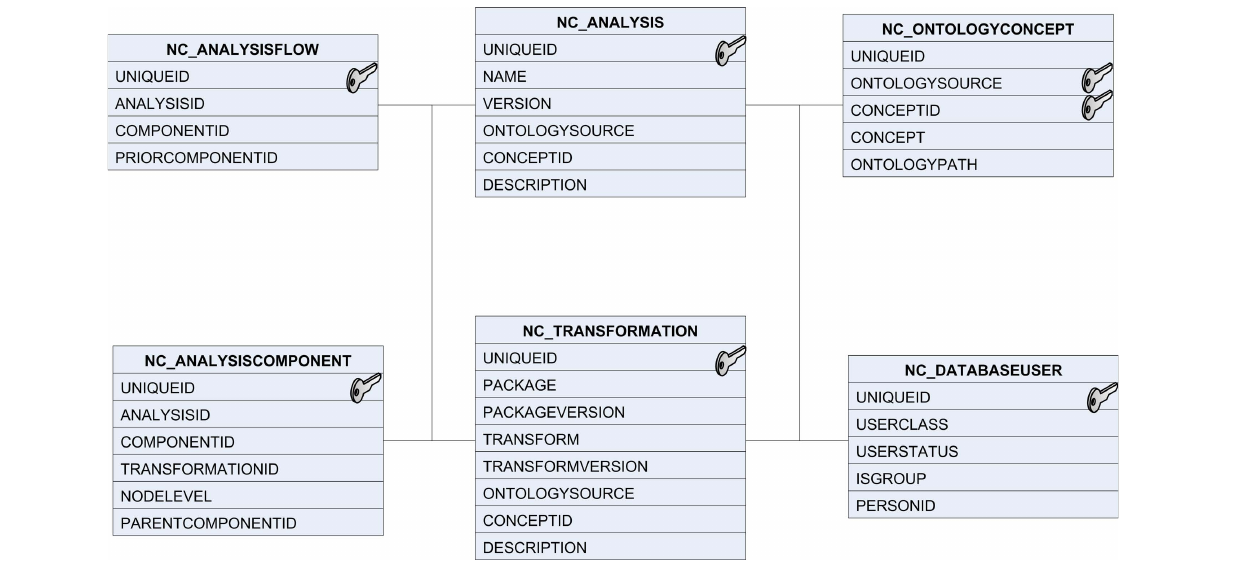
FIGURE 9 | Core HID tables for defi ning processing